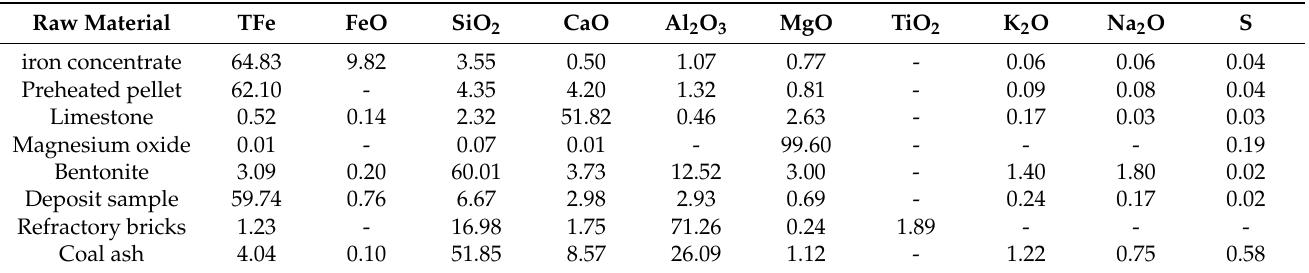
Table 1. Chemical compositions of raw materials (wt%).